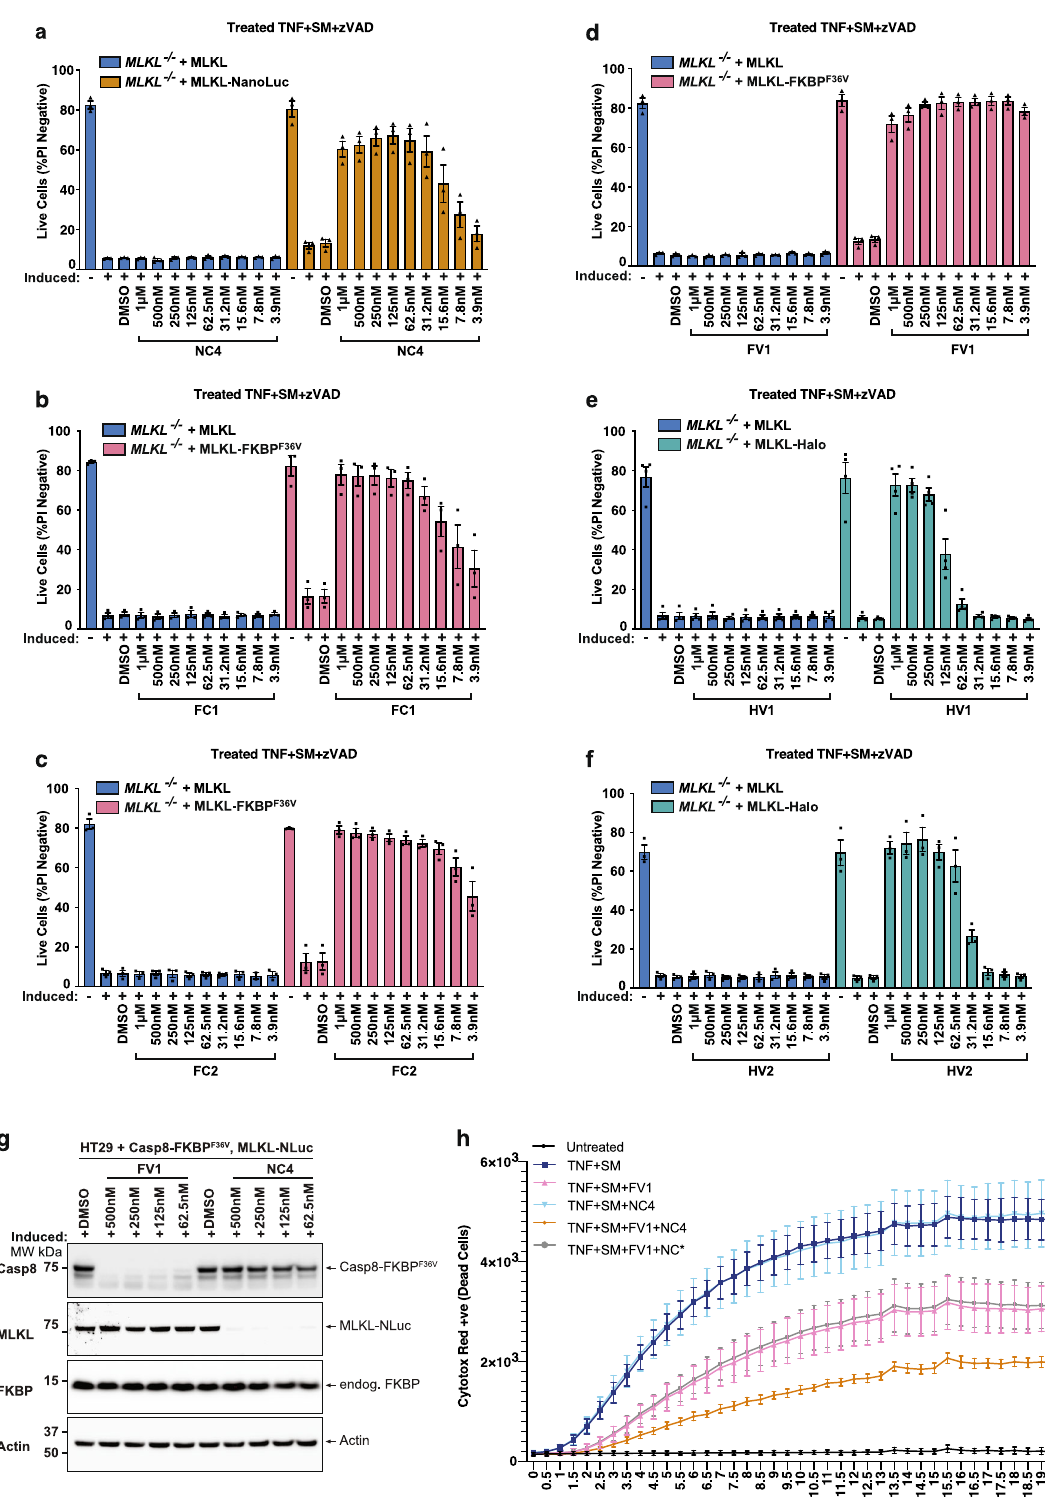
reductions in cell survival at lower concentrations, which may be attributed to the non-catalytic nature of these degrader compounds (Fig. 5e, f). Like NanoTAC degraders, FKBP F36V degraders and HaloPROTACs displayed no anti-necroptotic activity in MLKL − / − cells expressing untagged MLKL (Figs 5b – f) or wild-type HT29 cells (Supplementary Fig. 5g, h). A representative fl ow cytometry gating strategy that was used to analyse the induction of necroptosis is